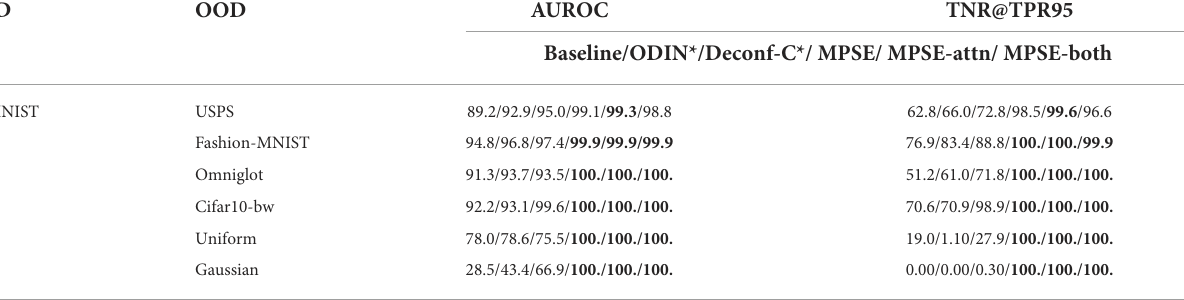
TABLE 1 Performance of the different methods in OOD (both SCOOD and DCOOD) scenarios, with the best results shown in bold. ID OOD AUROC TNR@TPR95